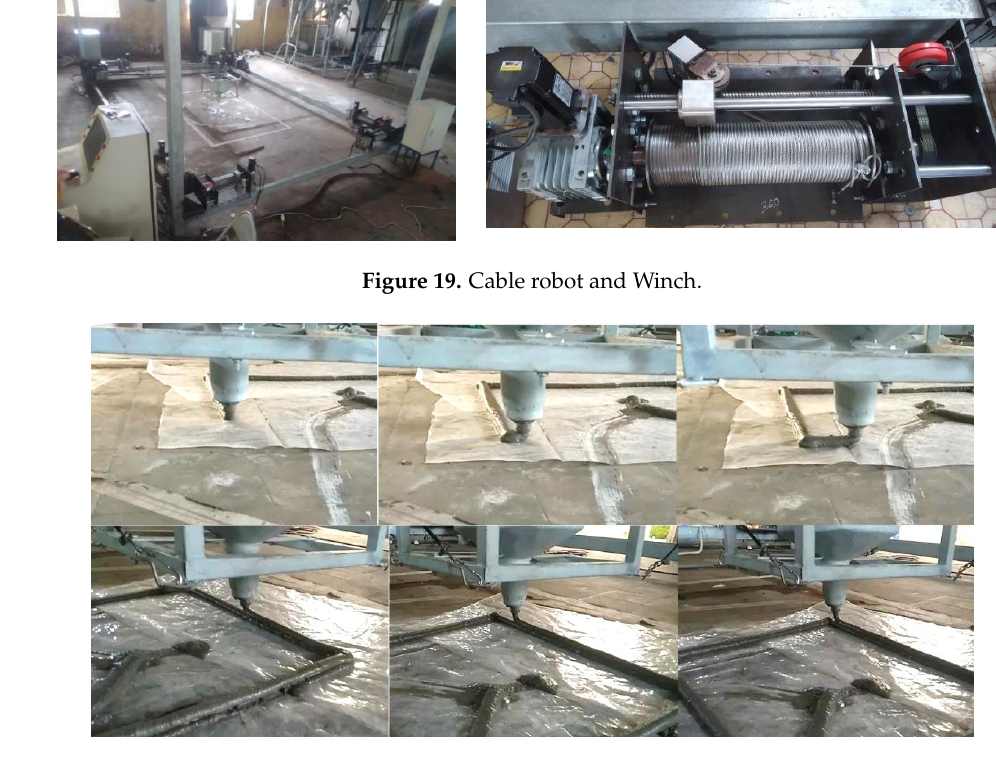
Figure 21. The two layers of square concrete of the experiment.